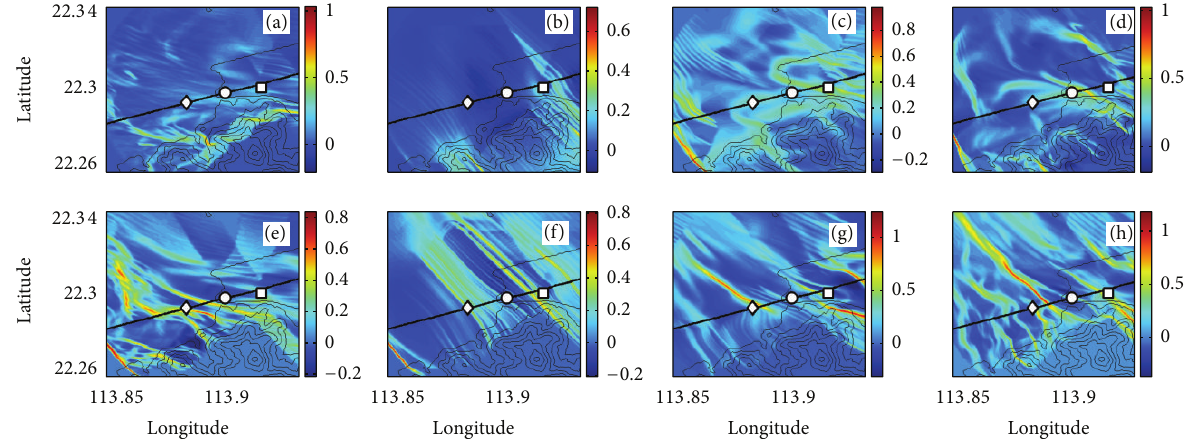
Figure 8: FTLE fields computed from LOS velocity and 2D variational retrieval. The panels are, from left to right, data from RAMS, FLOWSTAR, WRF, and LIDAR, respectively. The top panels are the forward time FTLE and the bottom panels are the backward time FTLE.